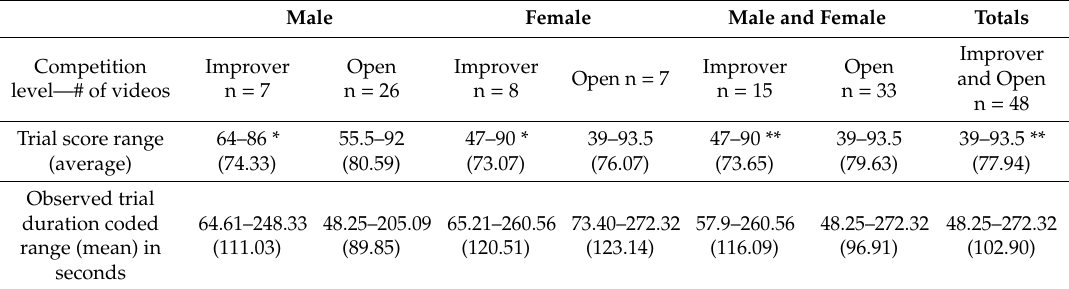
Table A2. Event-based lag sequential analysis results for sheep behaviour response to dog behaviour including observed frequencies, conditional probabilities and adjusted residuals.